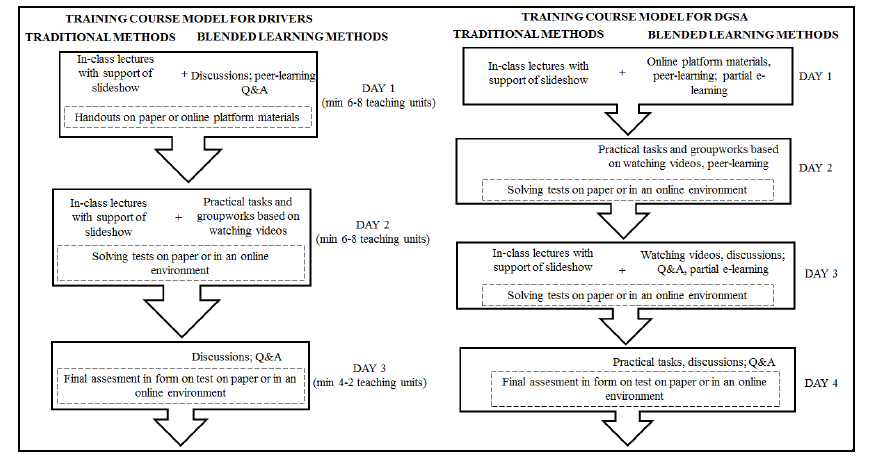
Fig. 4. Blended learning training course models. Source: